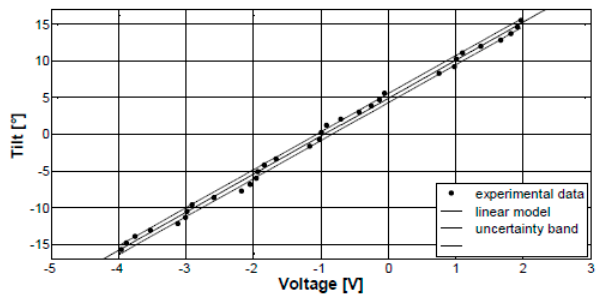
Figure 4. Normalized IR response as a function of the applied tilt.